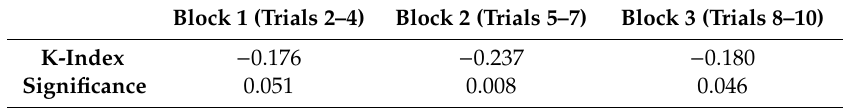
Table 1. Correlation between the K-Index from the Change Location Task and Trial Blocks in the Boxes Room Task.